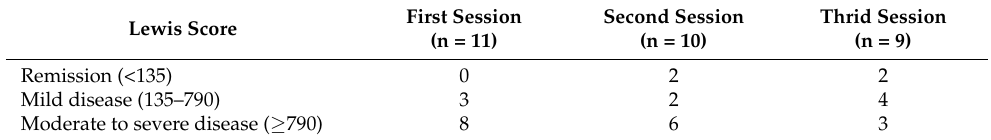
Table 3. Changes of lesion severity according to the Lewis score for Capsule